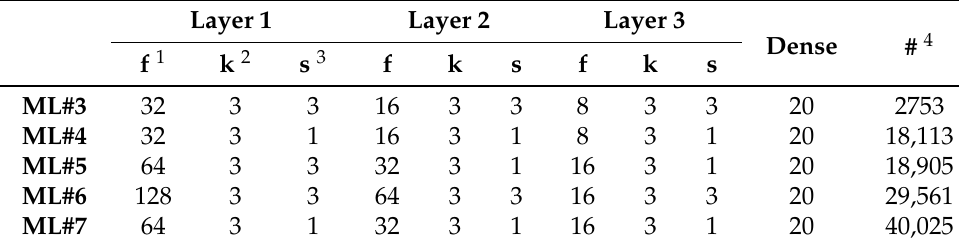
Figure 7. Network using convolutional layers. Table 2. Model architectures presented for CNNs.